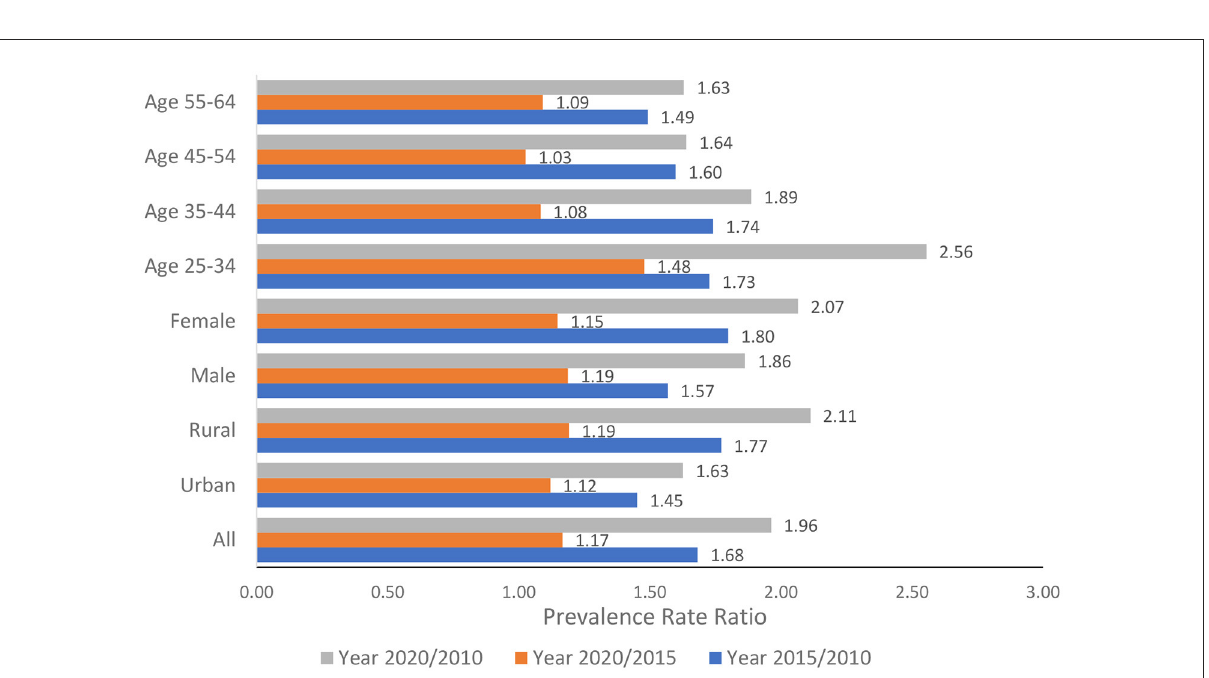
FIGURE2 Relative changes in the prevalence of overweight/obesity among the population aged 25–64 years over time.